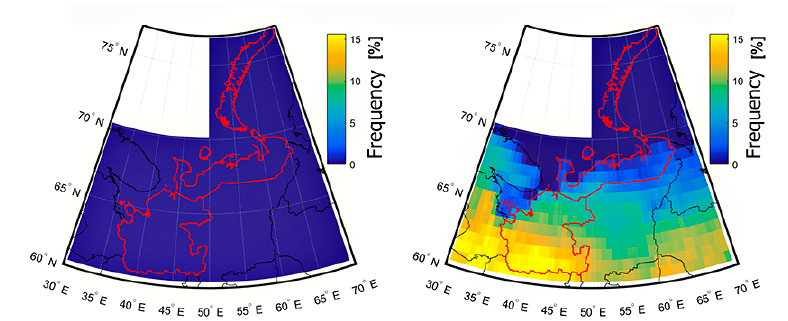
Figure 6. The spatial distribution of the frequency of days without heat stress (when the daily minimum and daily maximum both simultaneously satisfy the conditions) according to the PET (a) and UTCI (b) index